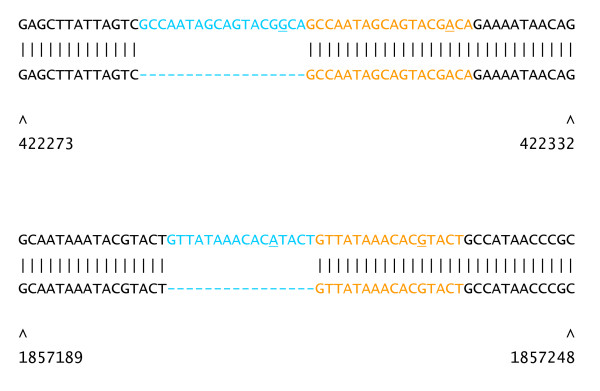
Two false-positive SNPs in Y. pestis map to imperfect repeat regions. (Top row) CO92 reference and (bottom row) non-reference genome, with CO92 coordinates indicated below. Repeat units are colored in alternating blue and orange text. (Top panel) An 18 bp tandem repeat in Y. pestis La Paz; (bottom panel) 16 bp tandem repeat in Y. pestis 90A-4021. Bases that differ from the consensus sequence are underlined.